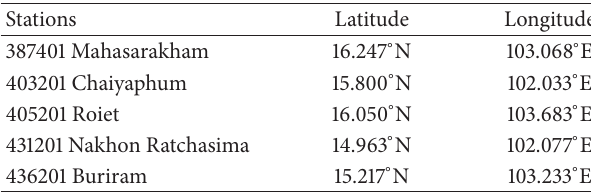
Table 1: Locations of the five meteorological